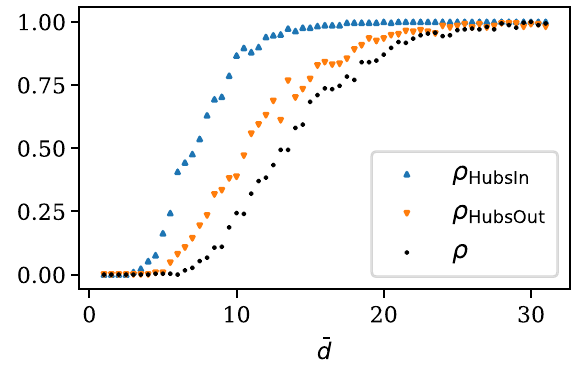
FIG. 8. Preferential sampling of hubs as input nodes (blue symbols) or output nodes (orange symbols) for an ensemble of 300 scale-free networks ( N ¼ 500 , M ¼ P ¼ 10 , and γ ¼ 2 . 4 ). The blue triangles show the fraction of invertible networks when the M ¼ 10 nodes with highest degree are chosen as input nodes, and the P ¼ 10 output nodes are sampled uniformly from the remaining N − M ¼ 490 nodes. Conversely, for the orange symbols, the P ¼ 10 nodes with highest degree are chosen as outputs, and the inputs are uniformly sampled from the remaining N − P ¼ 490 nodes. The black dots are obtained for the same uniform random scheme as in Fig. 6, where both inputs and outputs are sampled uniformly (scenario SC